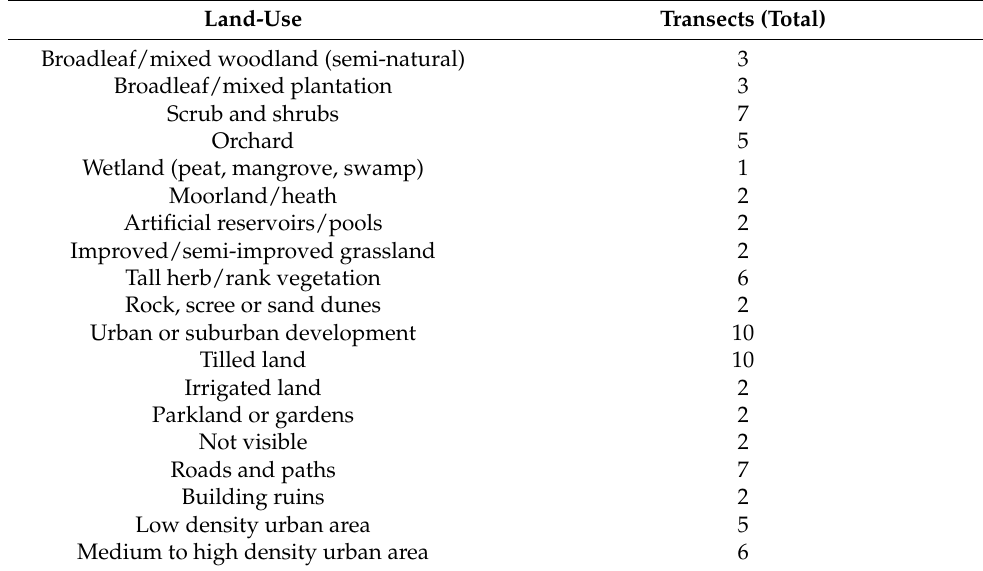
Table 4. Representativeness of observations in Section F.